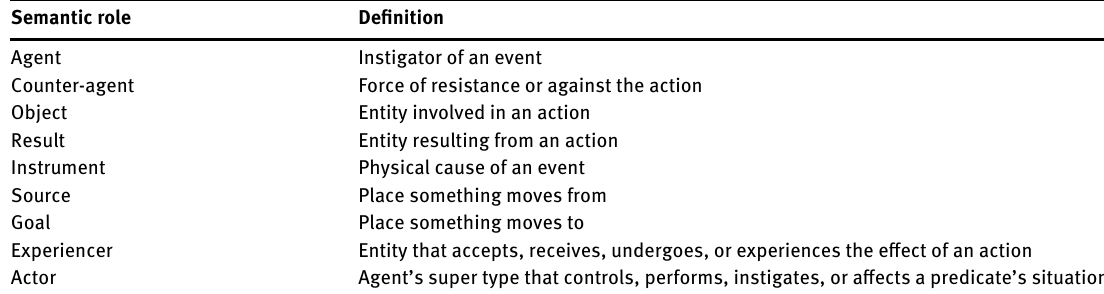
Table 3: Table 3 Some Semantic/Thematic Roles.